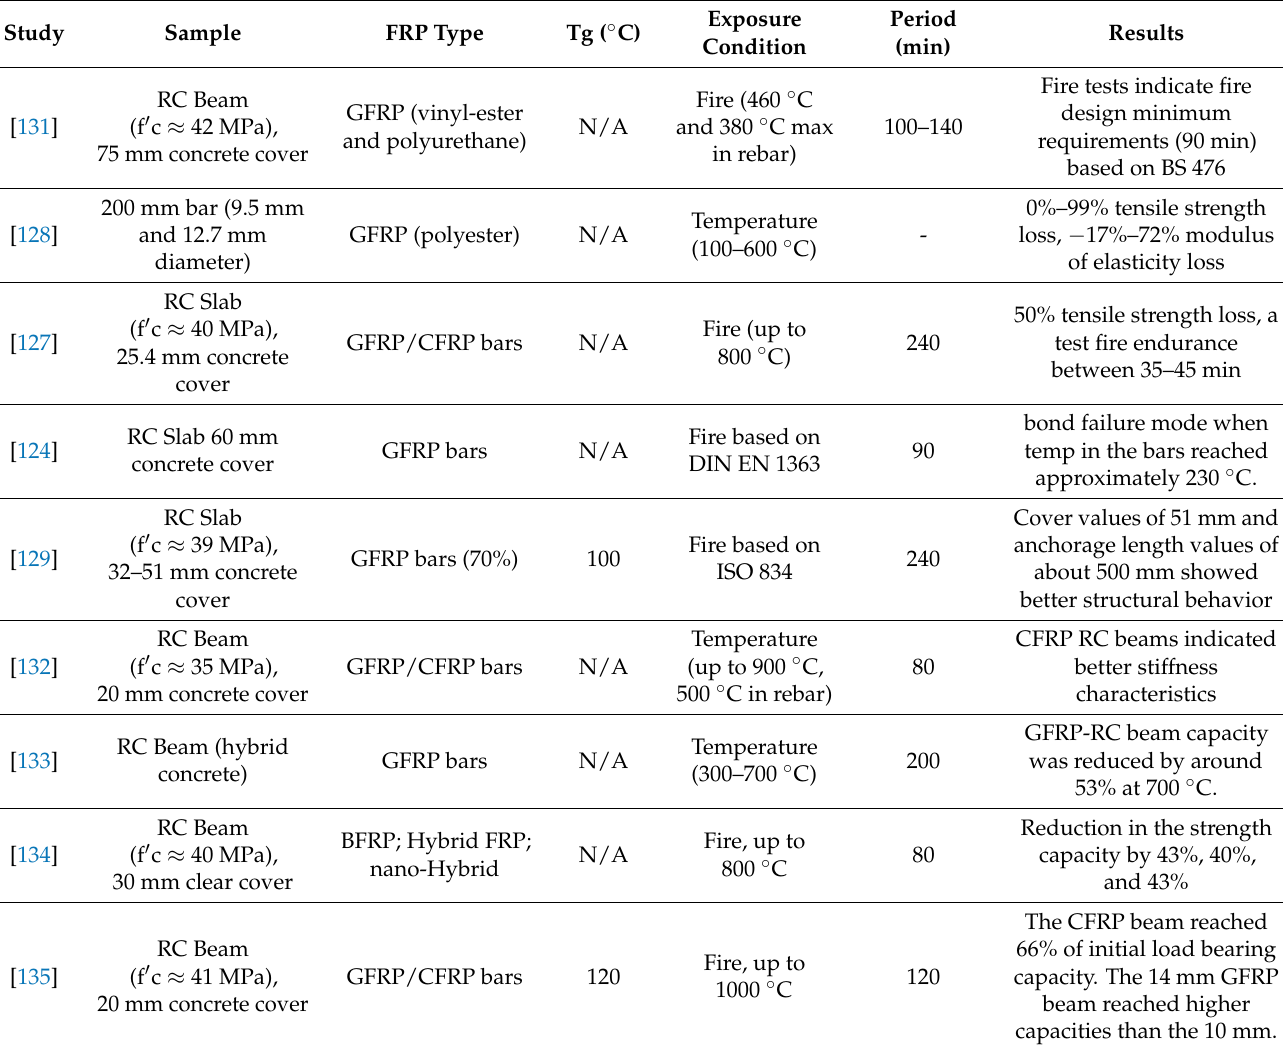
Table 2. Research studies of FRP-reinforced concrete members exposed to elevated